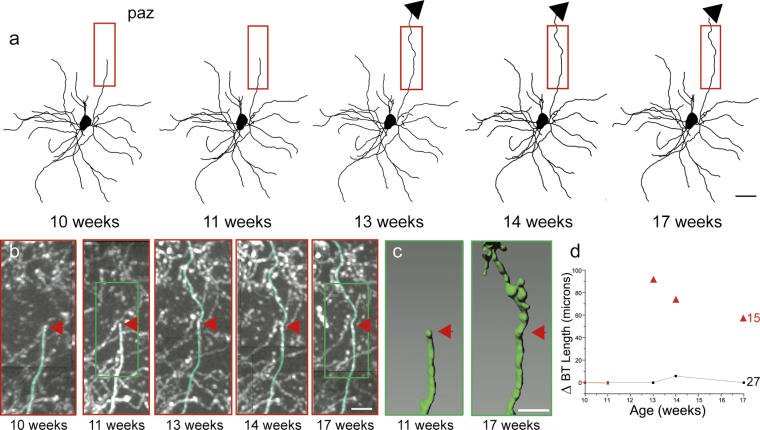
Large-Scale Dendritic Branch Growth in a Non-Pyramidal Neuron(A) Three-dimensional skeletal reconstructions of the non-pyramidal neuron “paz” from images acquired over 7 wk. Note that a growing branch tip exceeded the imaging volume after 11 wk, and black arrowheads denote its postulated continuation.(B) MZPs of region outlined by red box in (A). The branch tip (#15) elongates radially in the x–y-axis and away from the pial surface in the z-axis. Non-specific labeling in the MZP is exacerbated by the summation of additional z stacks due to elongation on the z-axis. The traced branch of interest is highlighted by a green overlay. Red arrowheads mark the approximate distal end of the branch tip at 11 wk.(C) Three-dimensional isosurface reconstructions of the region of the branch tip outlined by a green box in (B).(D) Plot of change in BTL of dynamic branch tips as a function of age. Triangles denote the minimum length of the branch tip as it exceeds the border of the imaging volume. Number to the right denotes branch tip number.Scale bars: (A), 25 μm; (B and C), 10 μm.